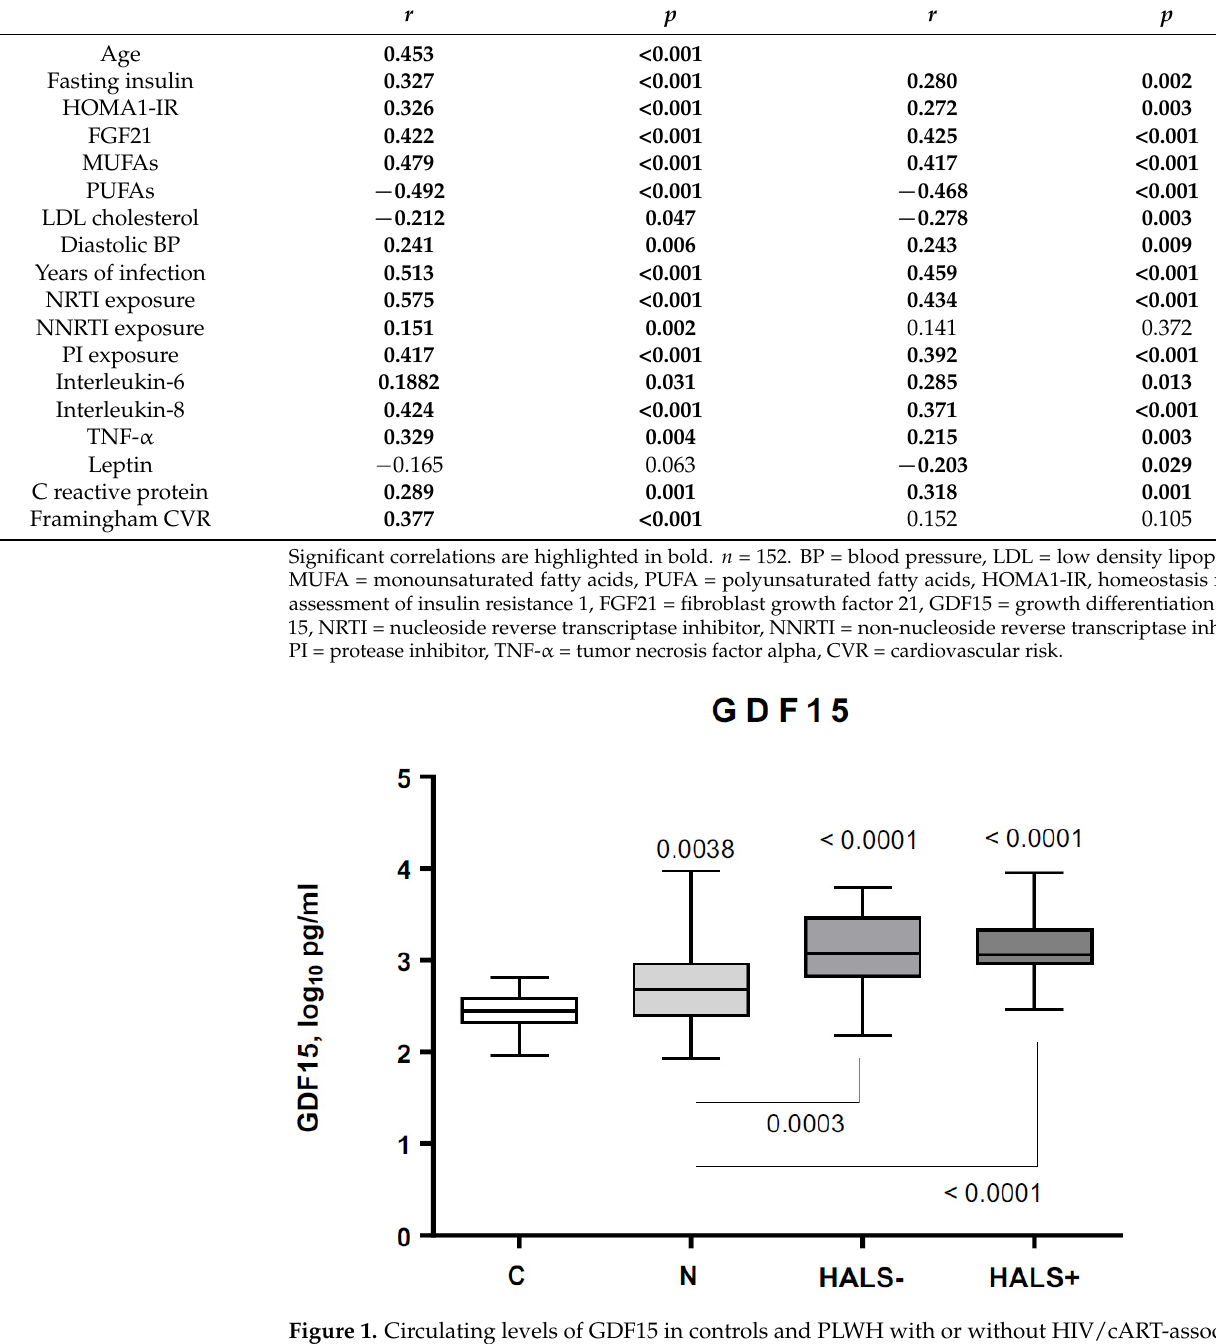
Table 3. Correlations of serum GDF15 levels with anthropometric, metabolic, infectious and treatment factors in PLWH.